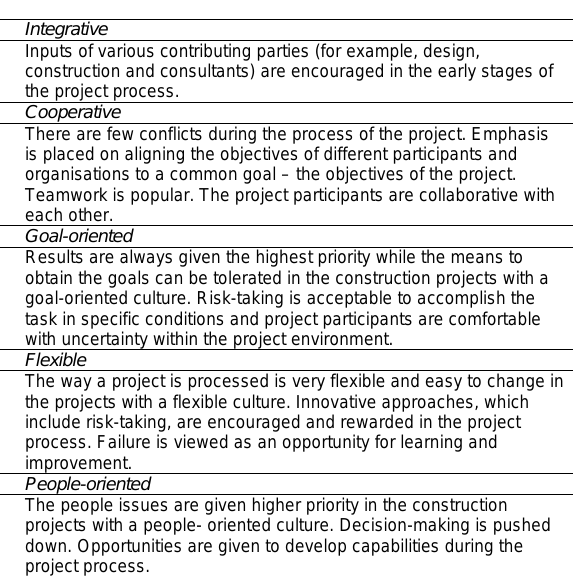
Table 1: The components of the proposed project culture